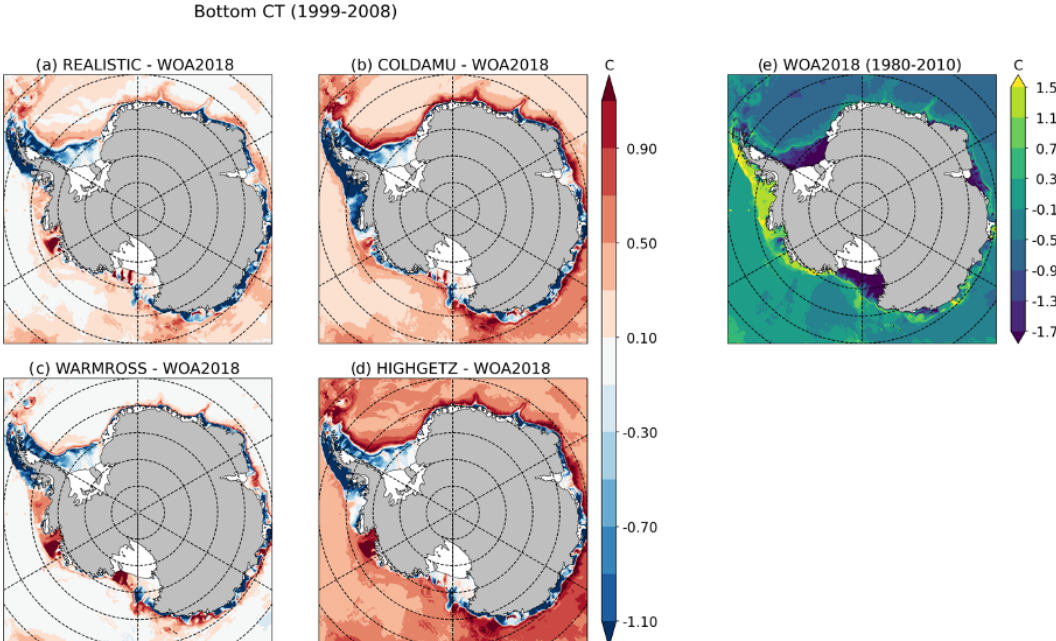
Figure B2. (a–d) Bottom conservative temperature (CT) averaged over the period 1999–2008 compared to WOA2018 bottom conservative